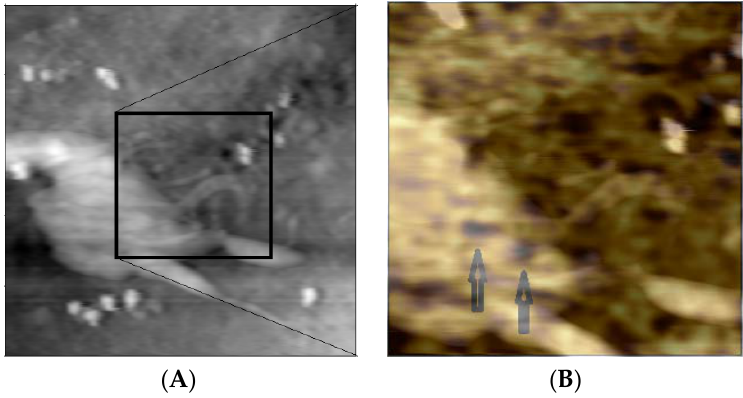
Figure 6. Topography (20 μm × 20 μm) ( A ) as in Figure 5 with the overlap of a zoomed area (9 μm × 9 μm) ( B ) of the optical map with the topography. The localization inside the cell of the two AuNPs is evident. (Reprinted from [41] with permission).